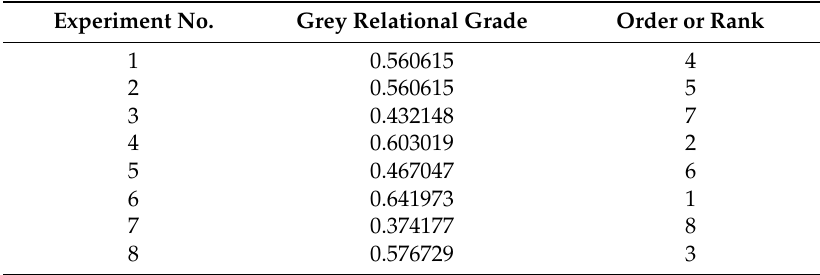
Table 10. Contribution of individual response to multi-response parameters.